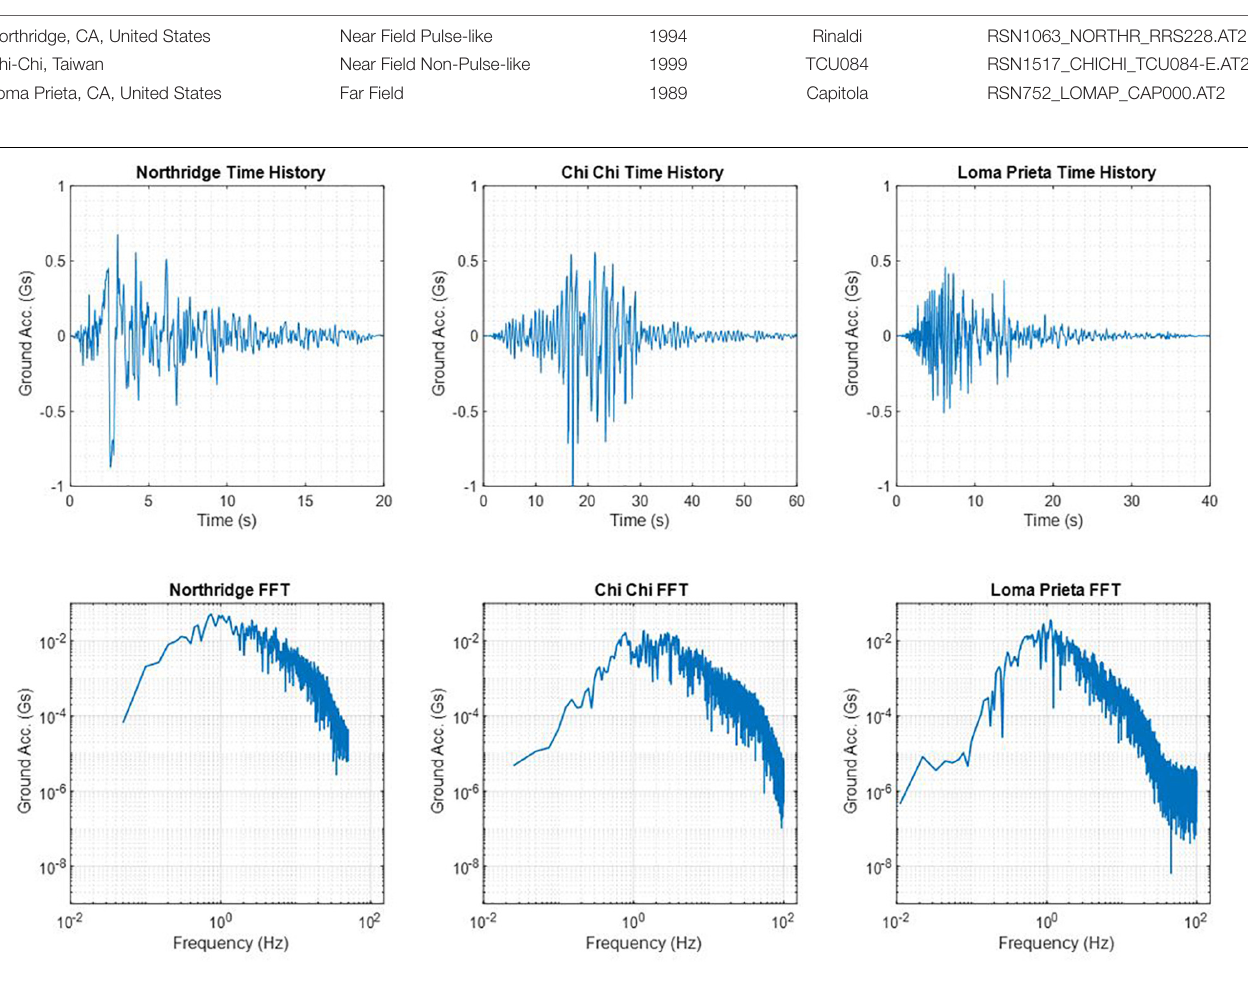
FIGURE 3 | Time histories and frequency content of the ground motions used for